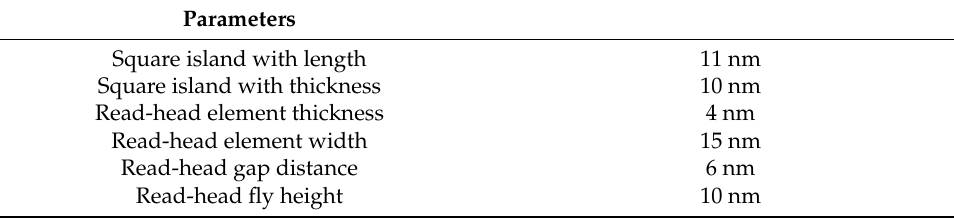
Table 1. Read-head and pulse response parameters.